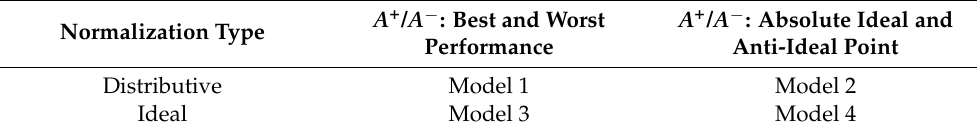
Table 6. List of the models